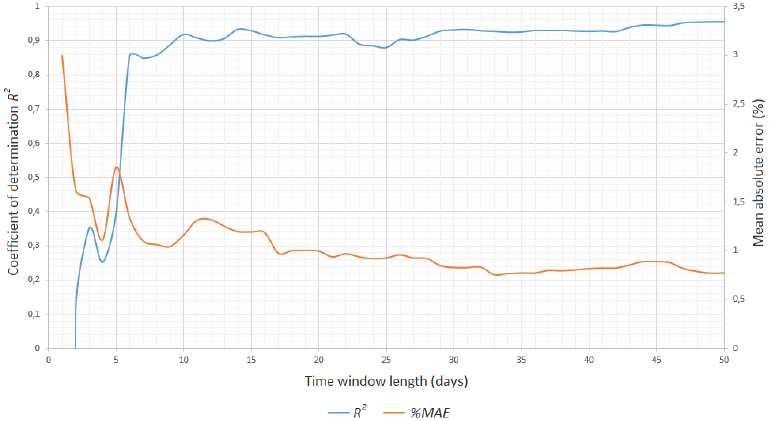
Figure 6. Mean absolute error in the time window length function.